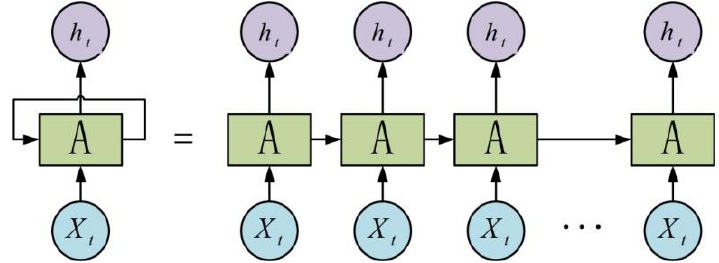
Figure 1. Computation flow of RNN model.